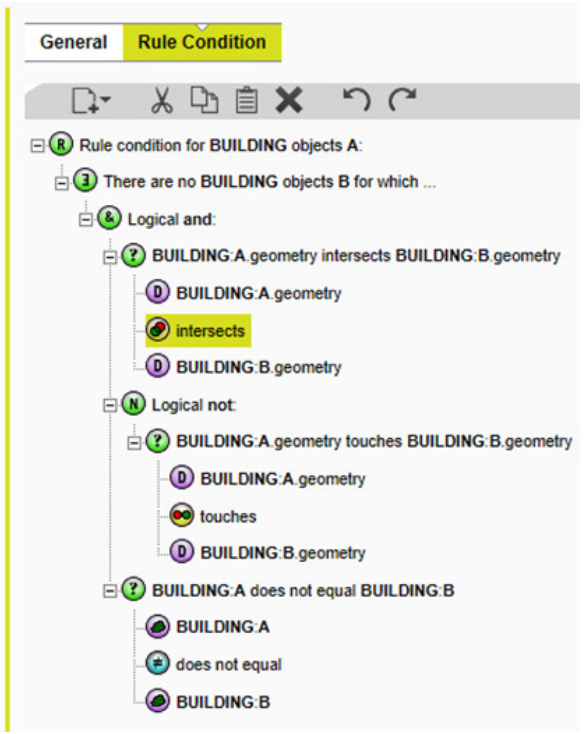
Figure 1: 1Validate rule